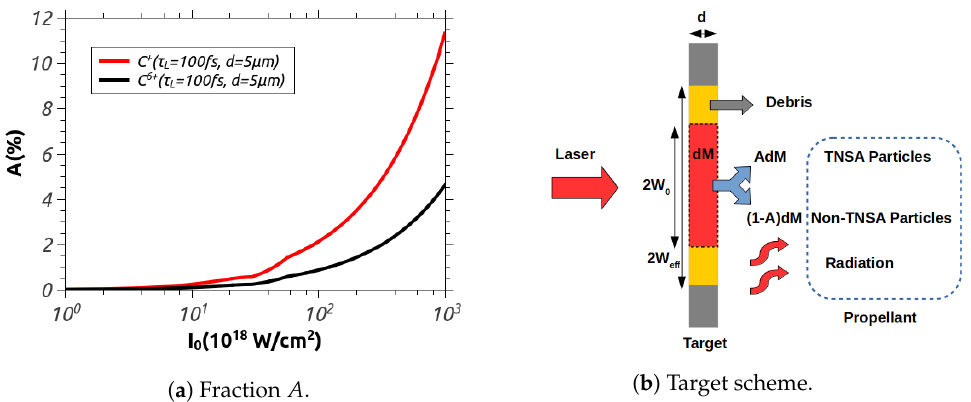
Figure 5. On the left, the fraction A of the TNSA accelerated particle as a function of laser intensity. Uniformly ionized C + and C 6 + targets, with thickness d = 5 µ m and density ρ = 1 g/cm 3 , irradiated by a laser pulse of duration τ L = 100 fs, have been considered. On the right, the scheme of a laser–solid target interaction. The propellant includes a variety of contributions including